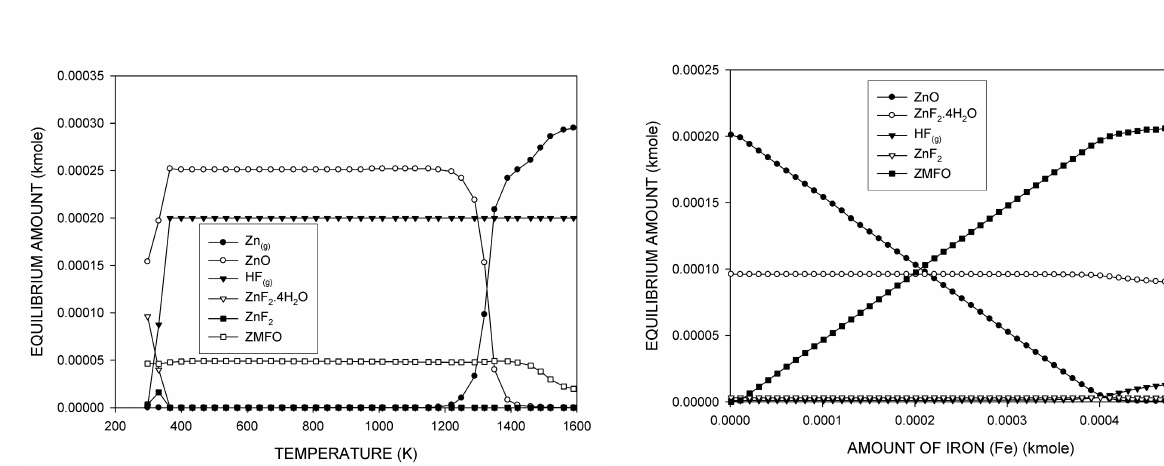
Figure 7(b). Effect of the amount of iron on the equilib- rium amounts of the zinc-containing species in the Zn-Fe- Mn-O-H-C-F system at room temperature.